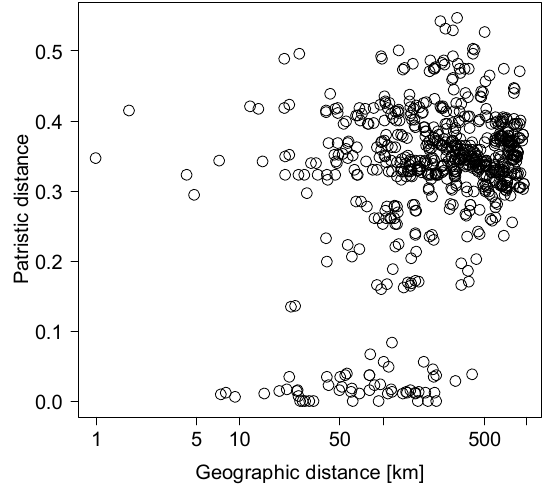
Figure 3. Relationship between pairwise genetic distances of the COI gene (patristic distances from tree shown in Fig. S3) and pair- wise geographic distances of Crenobia alpina populations across the European Alps. Note that the abscissa (geographic distance) is log 10